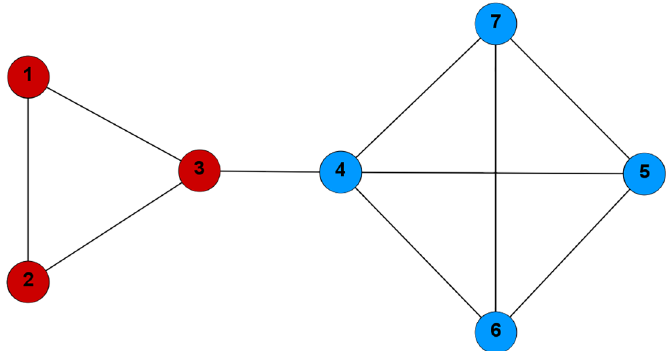
¼ f 1 ; 2 ; 3 g (red), C ¼ f 4 ; 5 ; 6 ; 7 g (blue) form the strategy profile s = (1, 1, 1, 1 2